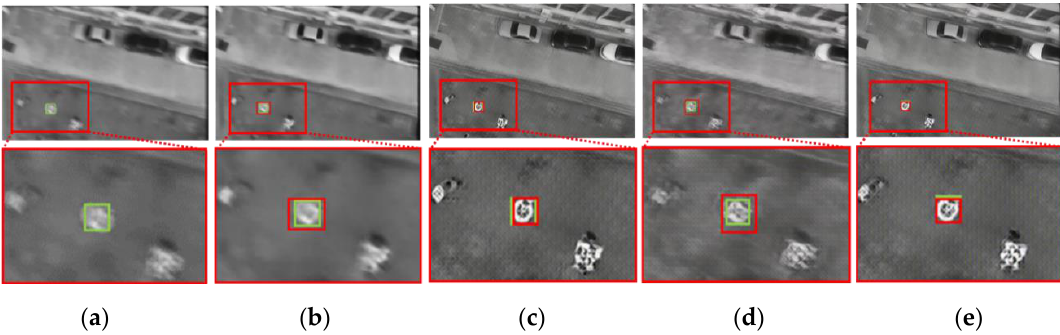
Figure 14. Examples of detection results on SMBD-DB1. The green boxes represent the ground truth bounding boxes and the red boxes represent the boxes detected by ( a ) YOLOv2, ( b ) DeepDeblur and YOLOv2, ( c ) a combination of DeblurGAN and YOLOv2, ( d ) a combination of DeblurGAN (MobileNet) and YOLOv2, and ( e ) a combination of SlimDeblurGAN and YOLOv2 (ours).